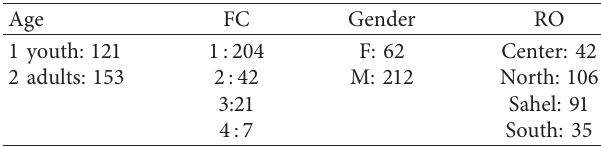
Table 1: Distribution of the consumers by age group, gender, region of origin, and frequency of consumption of VOO.